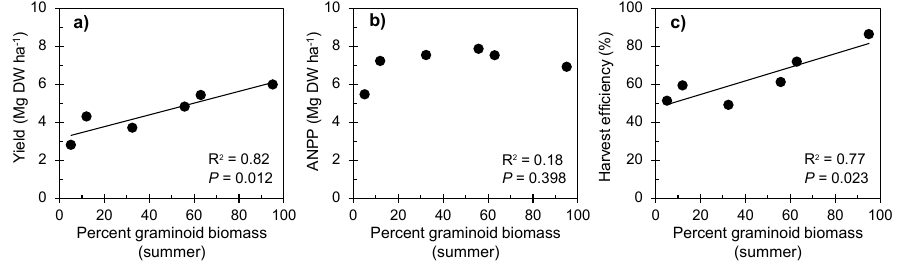
Figure 3. The relationship between graminoid biomass, as measured in at peak standing biomass in summer 2011, and ( a ) yield; ( b ) aboveground net primary productivity (ANPP); ( c ) harvest efficiency.